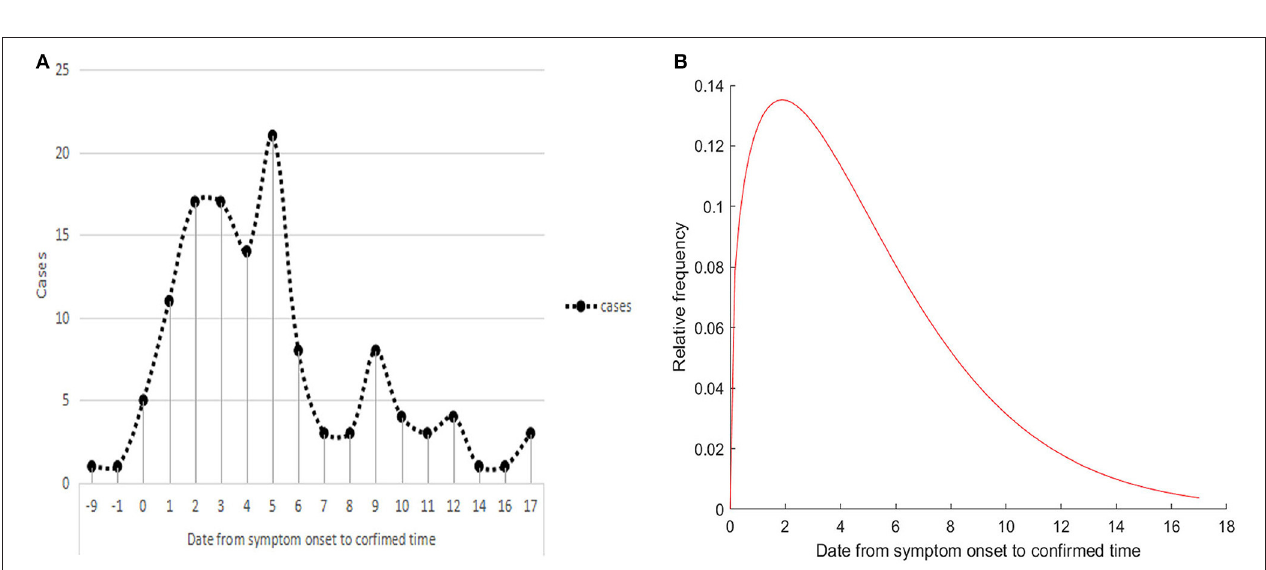
FIGURE 4 | The confirmed time of COVID-19. (A) Frequency distribution of confirmed times. (B) Estimation of the confirmed time by fitting a Weibull distribution.